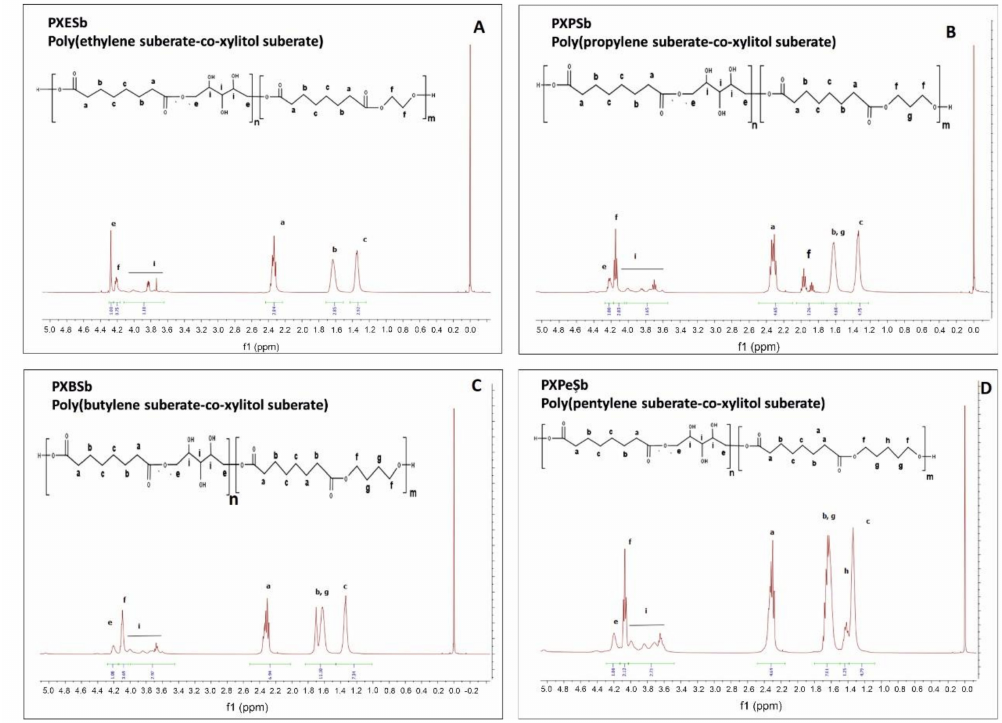
Figure 2. 1 H NMR of following prepolymers: PXESb ( A ), PXPSb ( B ), PXBSb ( C ), PXPeSb ( D ).